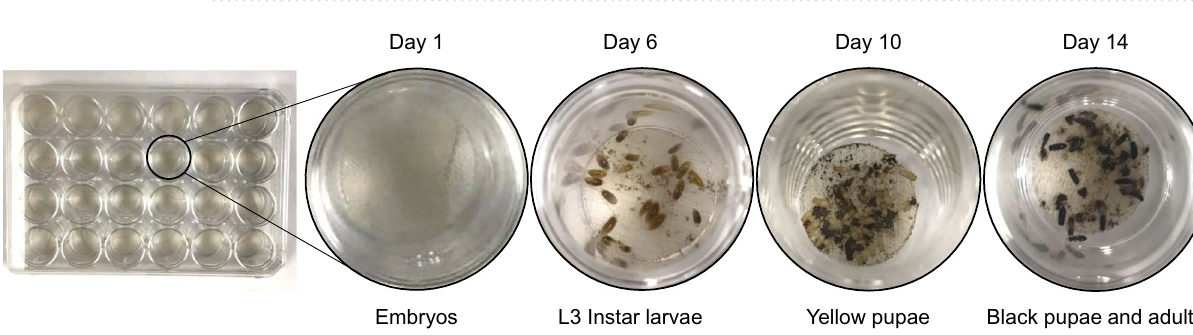
Figure 2. Photos of different stages Nasonia vitripennis in the rearing